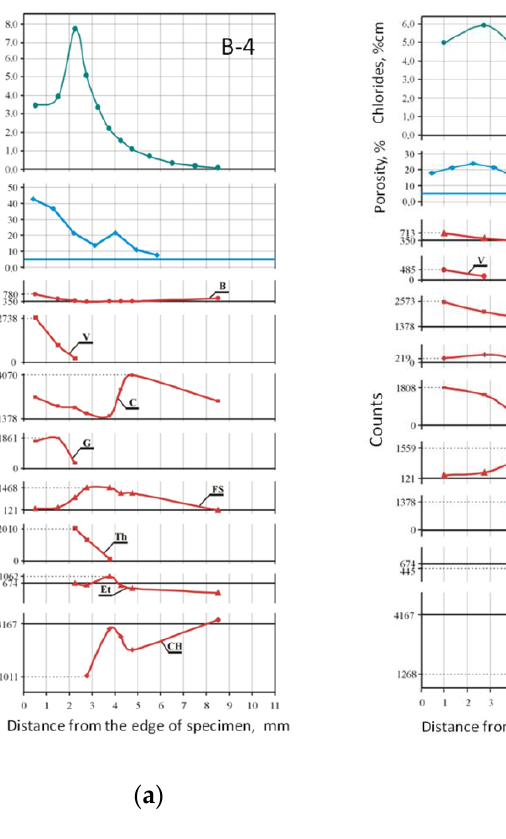
Figure 16. Changes in the concentration of free chloride ions (% of mass of cement), changes in porosity (%), changes in the phase content depending on the distance from the specimen’s surface in ( a ) B-4, ( b ) B-19 and ( c ) B-25, abbreviated names of phases — as in Table 6 and in Appendix A.